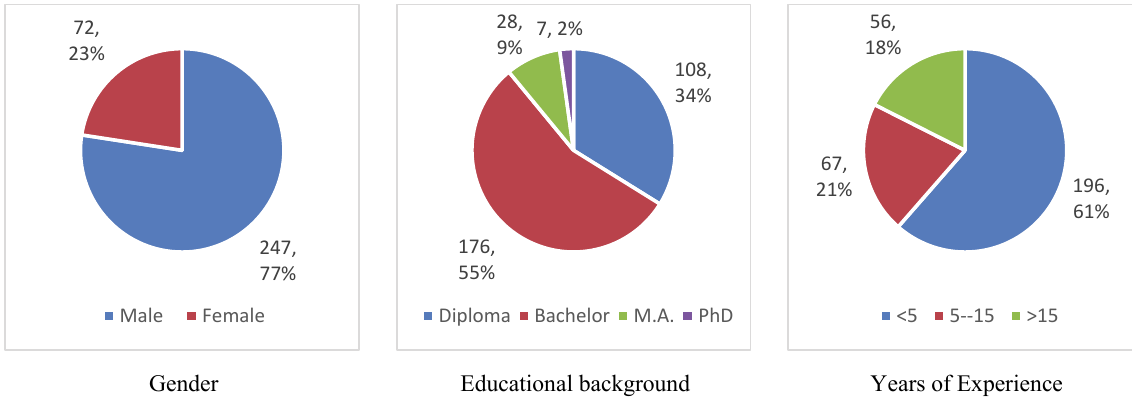
Fig. 2. Distribution of the sample according to the variables of the